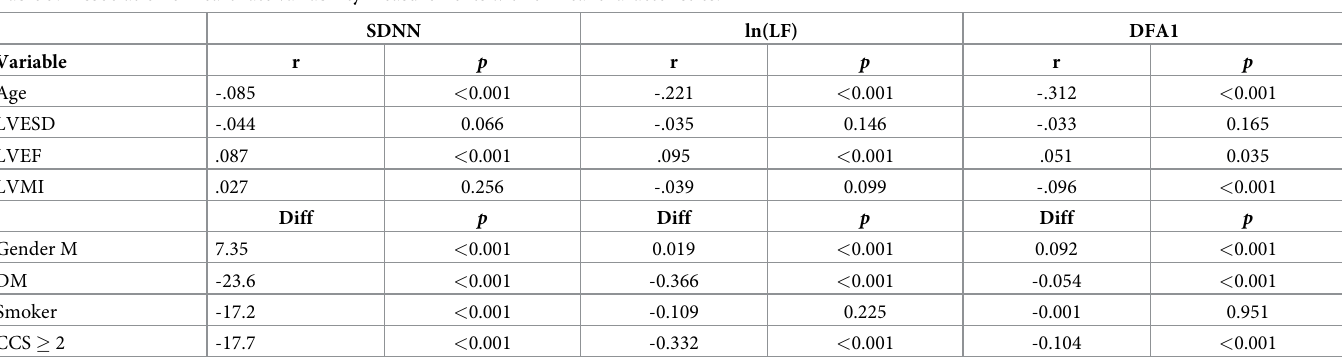
Table 3. Association of heart rate variability measurements with clinical characteristics.